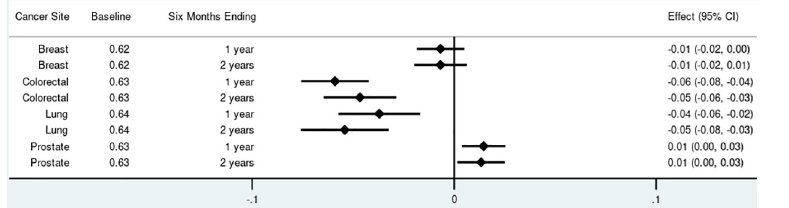
Fig 2. Total effect of cancer on proportion adherent (proportion of days covered > 80%) for statins by cancer site and phase of care. Point estimates and 95% confidence intervals.